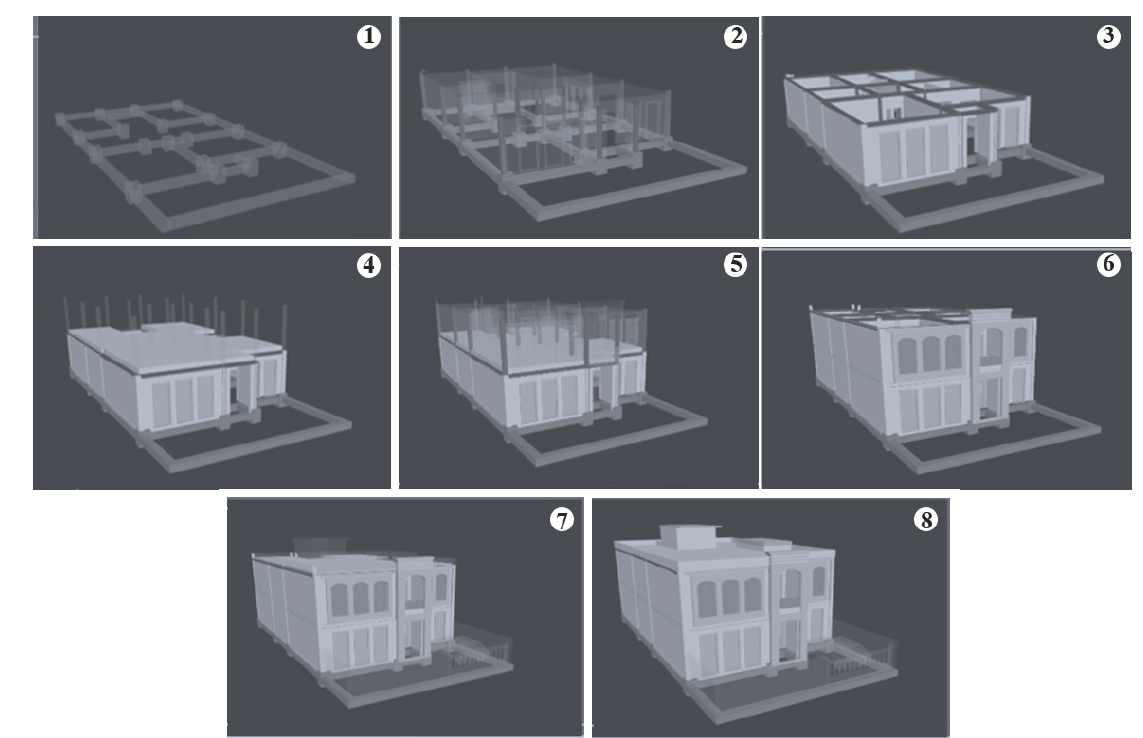
Figure 6. Simulating construction timeline with BIM from foundation to completion.